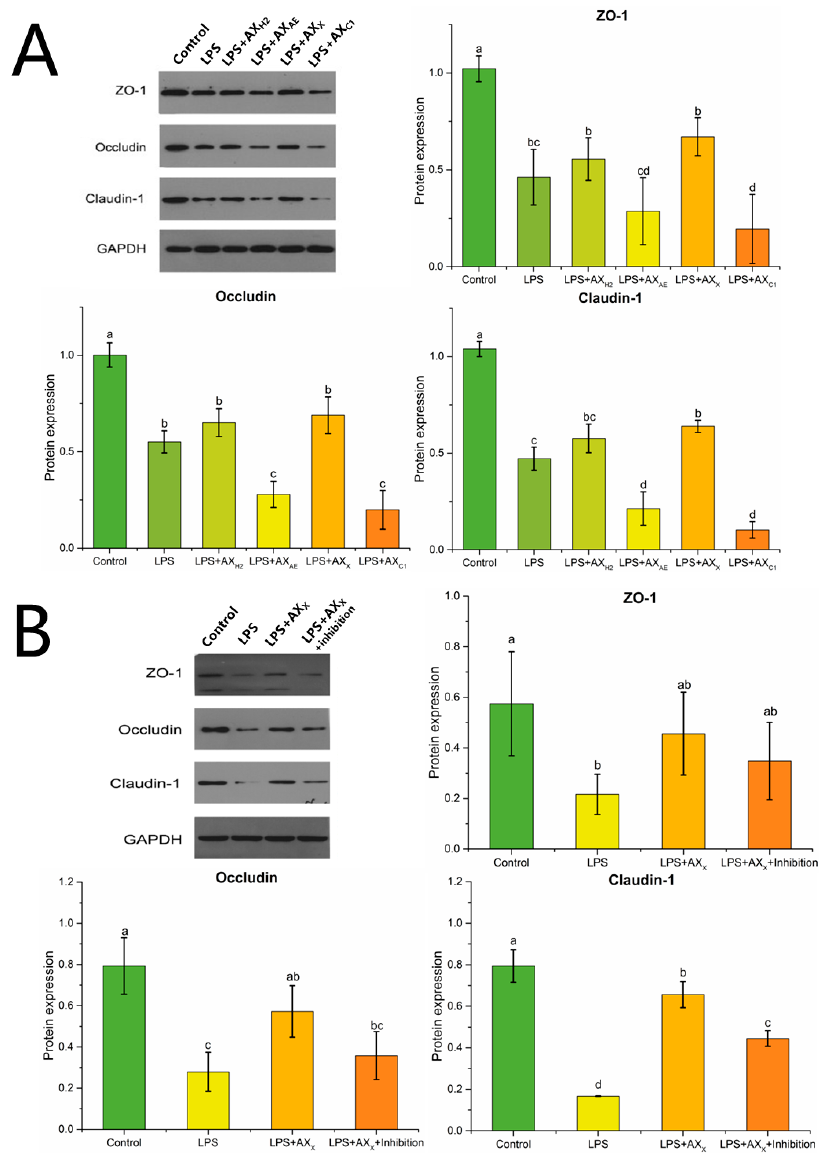
Figure 5. Tight junction protein expression in Caco-2 cells treated with ( A ) AXHs and ( B ) MyD88 inhibitor. Control, without LPS or arabinoxylan hydrolysates; AX H2 , triticale bran arabinoxylan was treated with 0.15 M HCl; AX AE , triticale bran arabinoxylan was treated with α -L-arabinofuranosidase; AX C1 , triticale bran arabinoxylan was treated with 0.1 M citric acid; AX X , triticale bran arabinoxylan was treated with endo-1,4- β -xylanase; Inhibitor, MyD88 inhibitor. Values represented in this figure consist of mean ± standard deviation ( n = 3). Values with different superscript letter are significantly different ( p < 0.05).